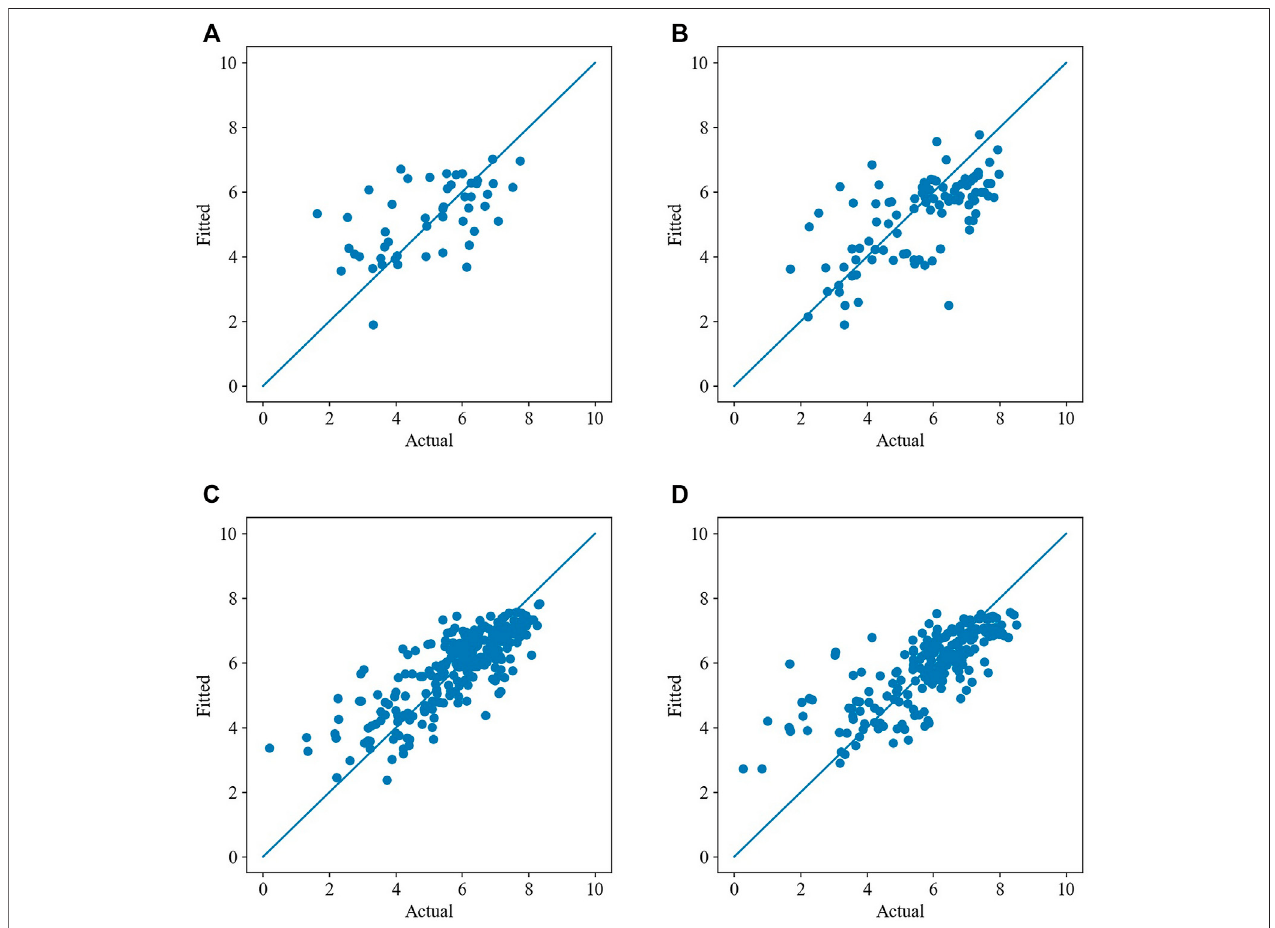
FIGURE 7 | Comparison plots are provided with x -axis as the actual values in test set of drought-affected area and y -axis as the fi tted values of the RF model. (A) 2011 – 2019. (B) 2004 – 2019. (C) 1987 – 2019. (D) 1979 – 2019.